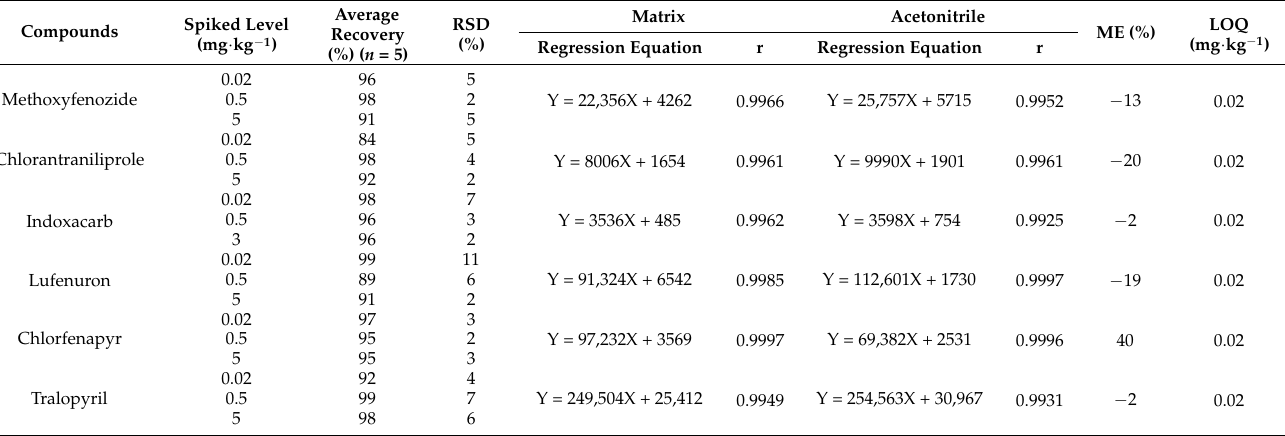
Table 2. Performance characteristic of the method for six compounds in